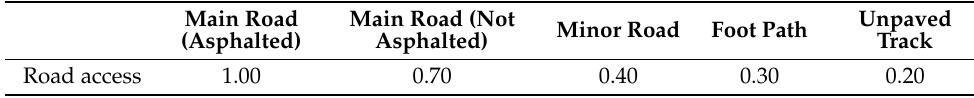
Table 4. Sample land price ratio table (road access).